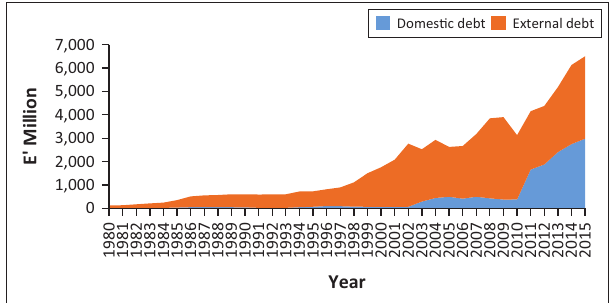
FIGURE 3: Composition of public debt.